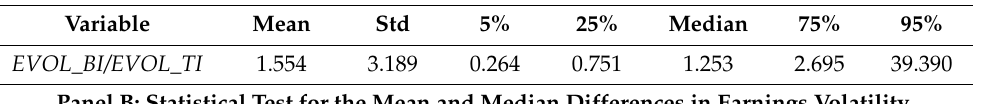
Table 3. The difference in the earnings volatilities between the book and taxable income. Panel A: Distribution of the Ratio of Book Income Volatility to Taxable Income Volatility Variable Panel B: Statistical Test for the Mean and Median Differences in Earnings